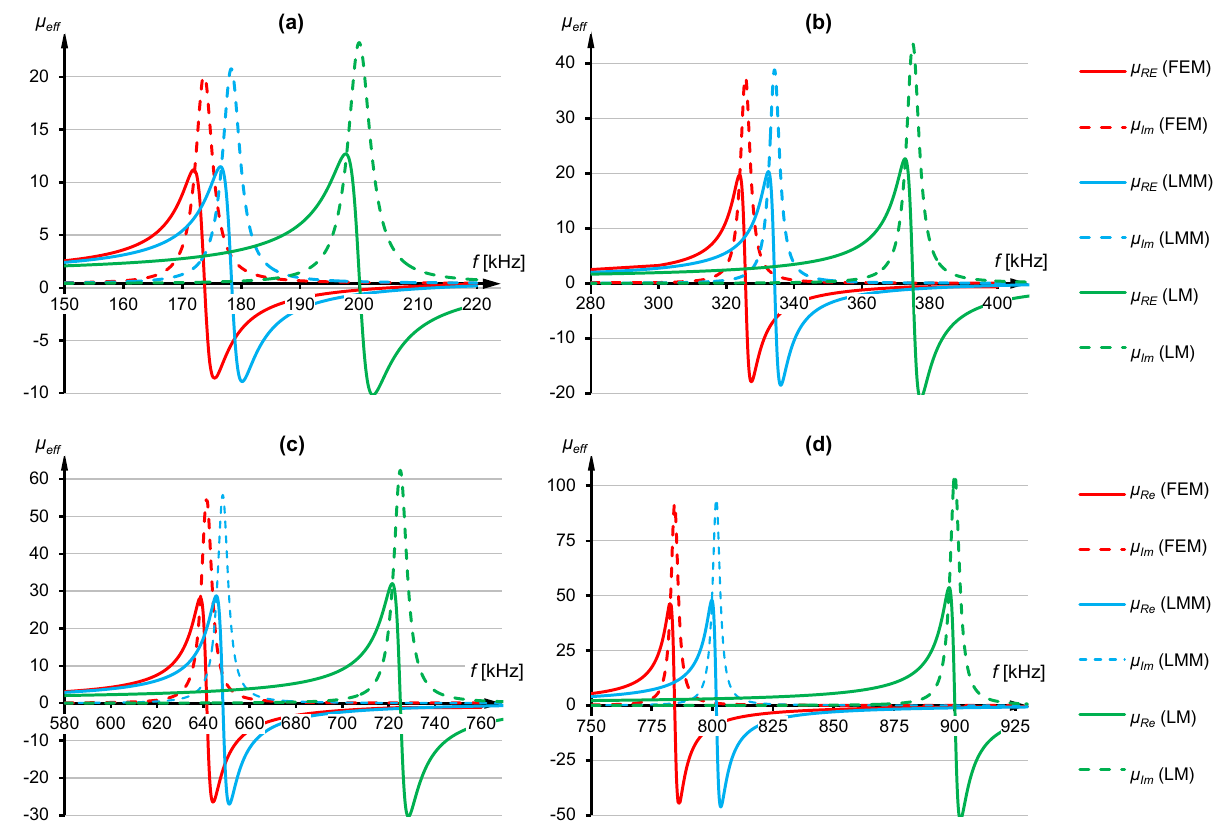
Figure 5. Real and imaginary parts of the effective permeability obtained using three models at h = d w /2, for specified resonant frequencies: ( a ) f z = 200 kHz. ( b ) f z = 375 kHz. ( c ) f z = 725 kHz. ( d ) f z = 900